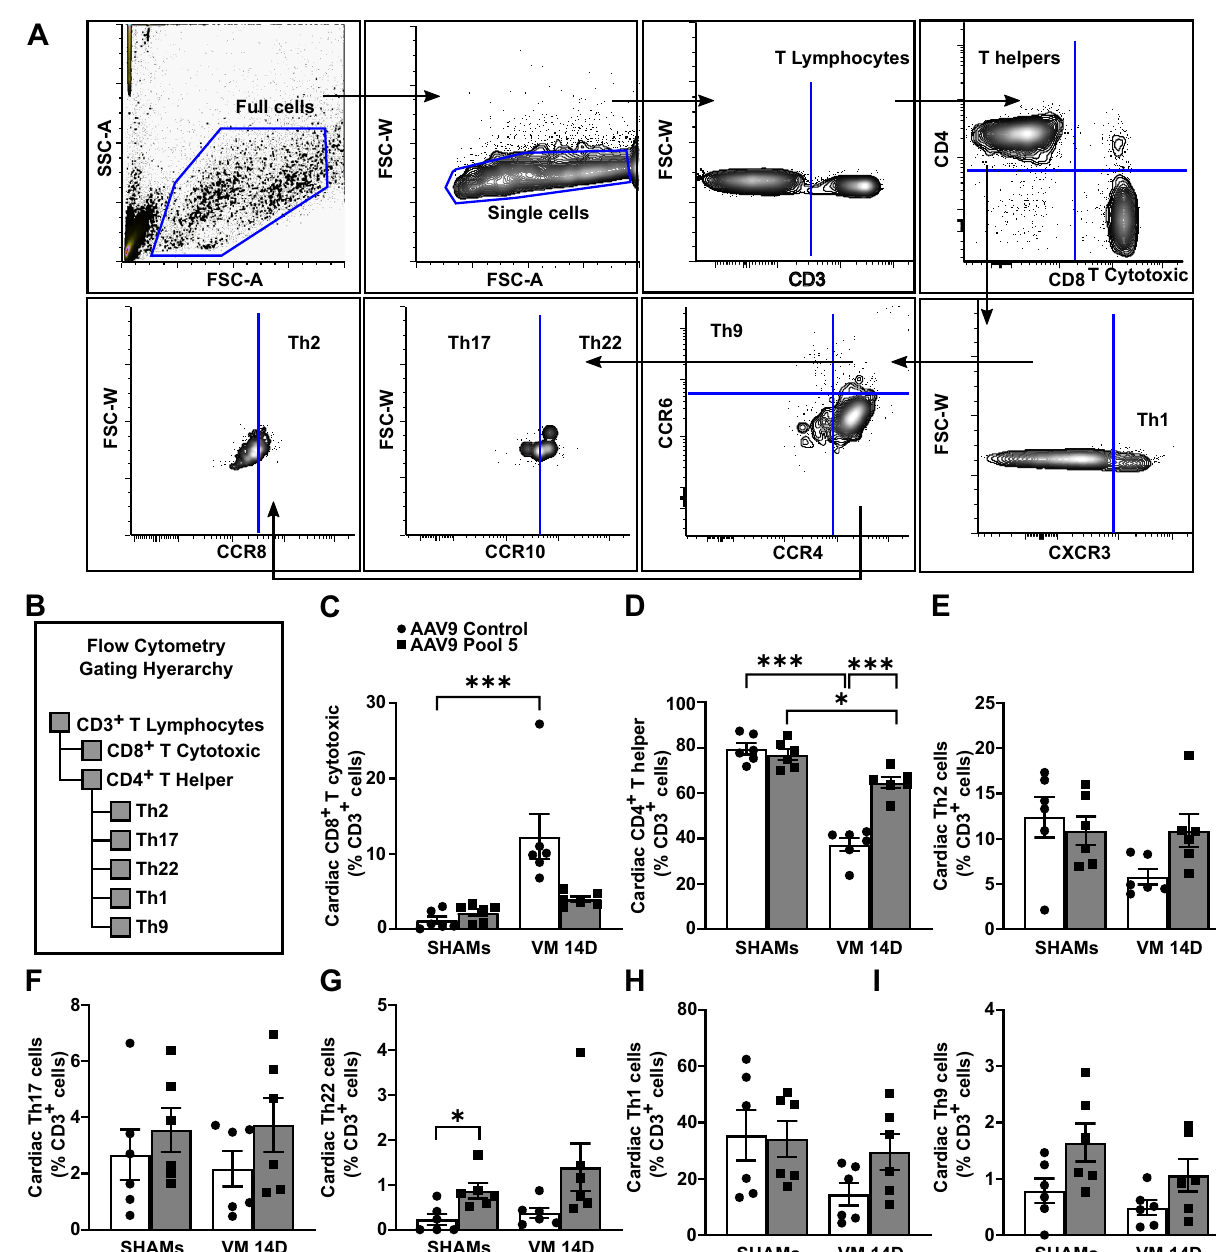
Figure 4. Overexpression of Pool 5 alters cardiac T cytotoxic and T helper lymphocyte balance in the acute phase. ( A , B ) Flow cytometry gating strategy and hierarchy to detect T lymphocyte subpopulation at 14 days post-infection in Pool 5-overexpressing hearts and controls. ( C ) T cytotoxic and ( D ) T helper lymphocytes detected by flow cytometry in Pool 5-overexpressing hearts and controls at 14 days post-infection. Significance assessed by a Kruskal–Wallis test ( C ) and a two-way ANOVA ( D ), followed by Tukey’s test with *p ≤ 0.05; ***p ≤ 0.001. ( E ) T helper 2 lymphocytes (Th2), ( F ) Th17, ( G ) Th22, ( H ) Th1, and ( I ) Th9 detected by flow cytometry in infected Pool 5-overexpressing hearts and infected controls 14 days after CVB3 infection. Significance assessed by Kruskal–Wallis test with *p ≤ 0.05 for panels ( E ), ( F ), and ( G ) or two-way ANOVA followed by Tukey’s test for panels ( H ) and ( I ). All values are expressed as mean ±